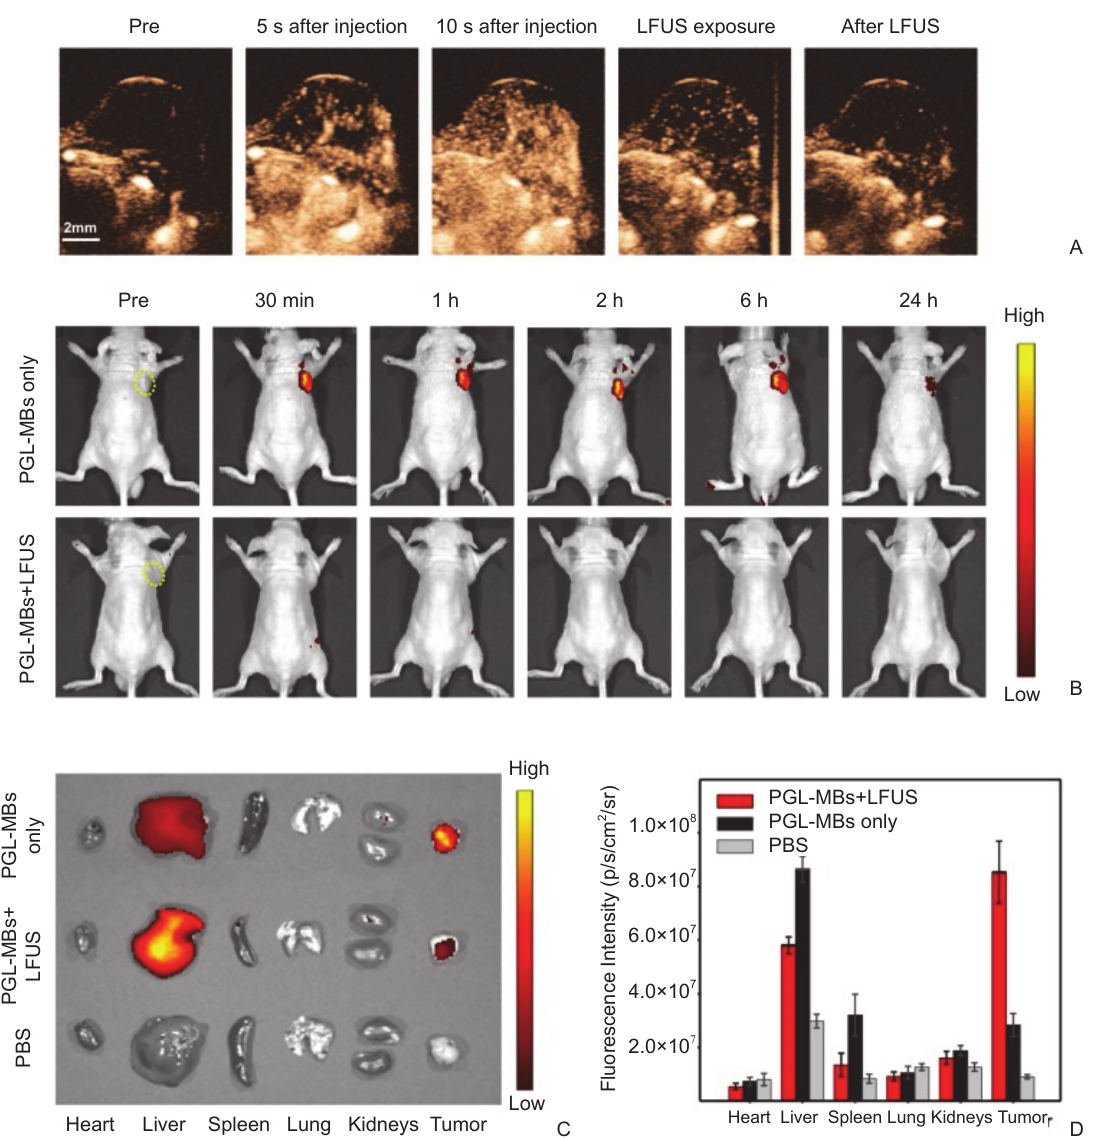
Figure 5 In vivo CEUS and fluorescence imaging in a subcutaneous PC-3 tumor model. (A) In vivo CEUS in a subcutaneous PC-3 tumor model. CEUS imaging of the tumor site before (pre) and after intravenous administration (i.v.) of PGL-MBs; (B) Fluorescence imaging in vivo at different time points after intravenous administration of PGL-MBs, with or without LFUS (400 kPa, 3 min) exposure. Tumors are circled with yellow dashed lines; (C) Images of organs excised at 24 h after injection. Organs of tumor-bearing mice without PGL-MBs injection were excised as negative controls; (D) Quantitative analysis of fluorescence intensity for the excised organs ( n = 3). (Reprinted with permission from reference [22])